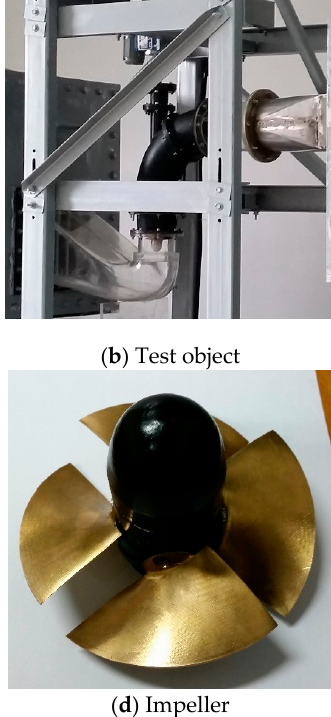
Figure 8. Energy performance repeatability test of axial-flow pump device.